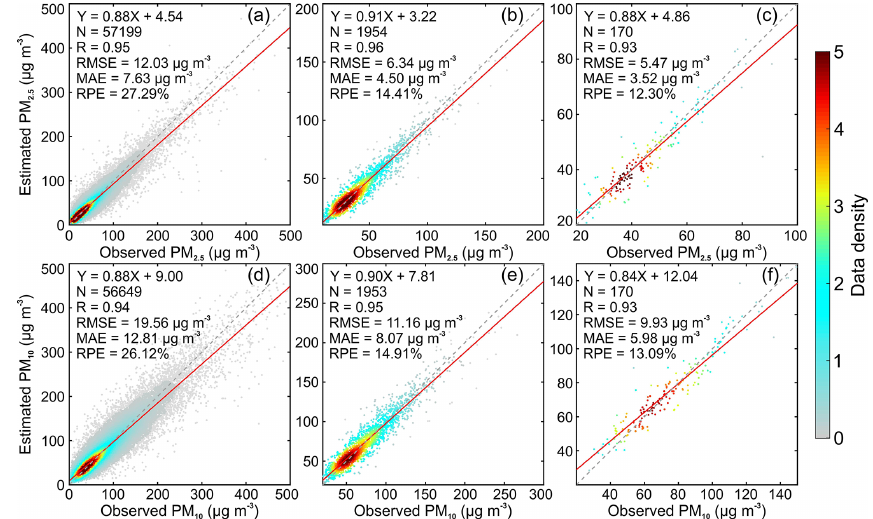
Figure 6. Scatterplots between observed and estimated PM 2 . 5 and PM 10 concentration. Panels (a) – (c) denote daily, monthly, and annual mean PM 2 . 5 validation results, respectively, while panels (d) – (f) are for PM 10 concentration. The ground measurements were acquired from 30 independent air quality monitoring sites that were randomly held out before the model training.